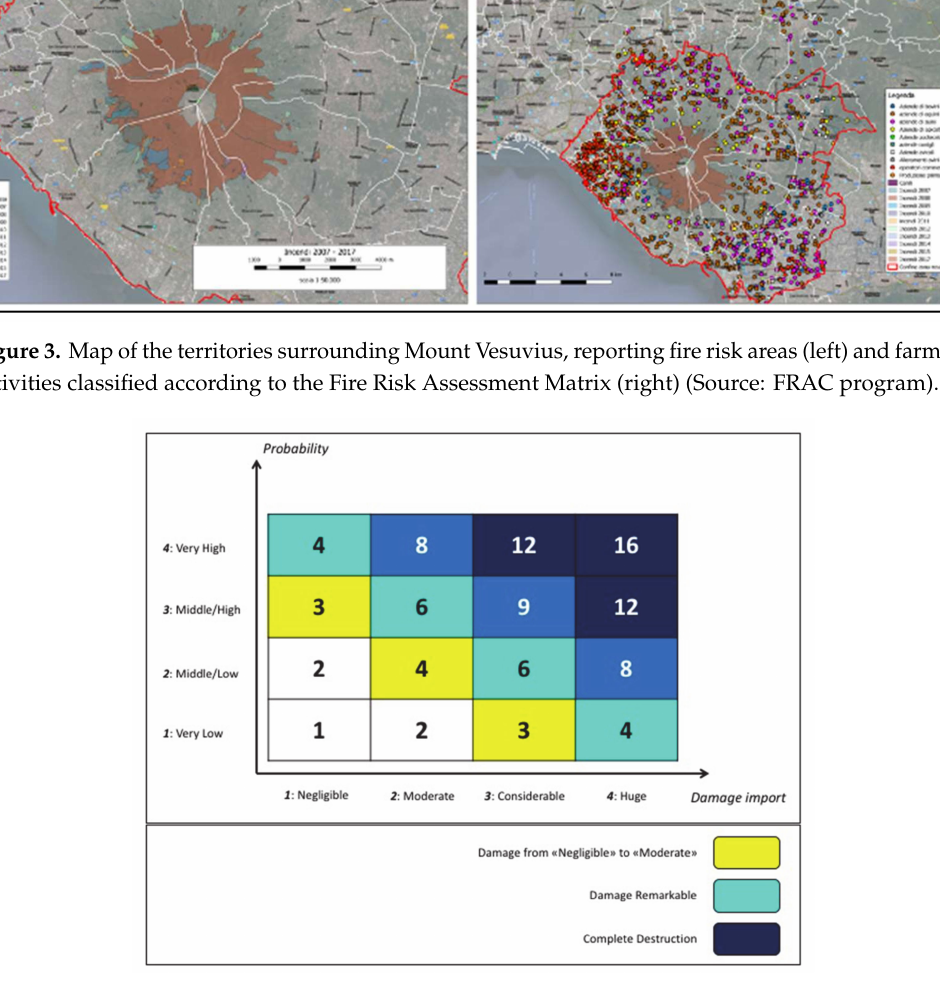
Figure 4. Fire Risk Assessment